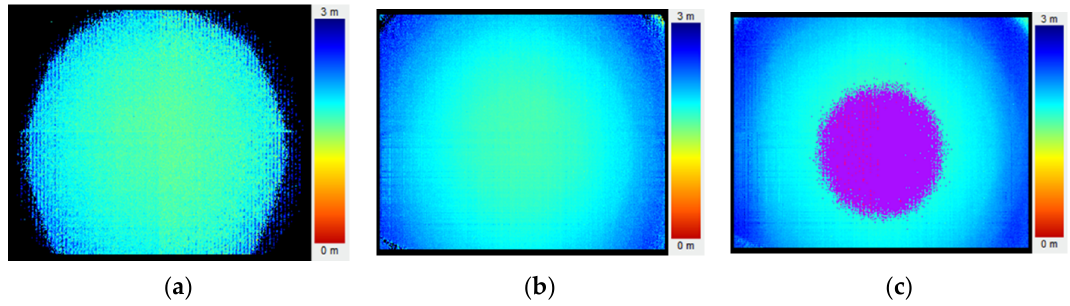
Figure 3. Depth images under different integration time. ( a ) under 50 μ s; ( b ) under 300 μ s and ( c ) under 650 μ s. The images were captured with a flat board.